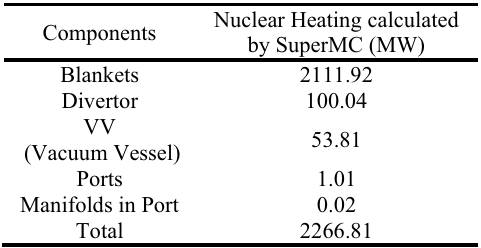
Table II. The breakdown of Nuclear Heating in reactor